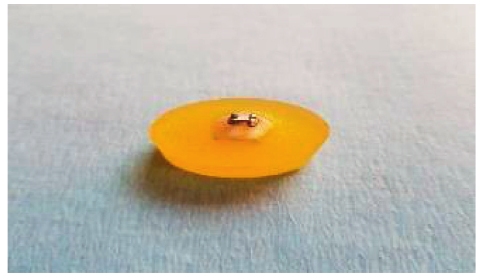
Figure 1: Tooth embedded in a holder